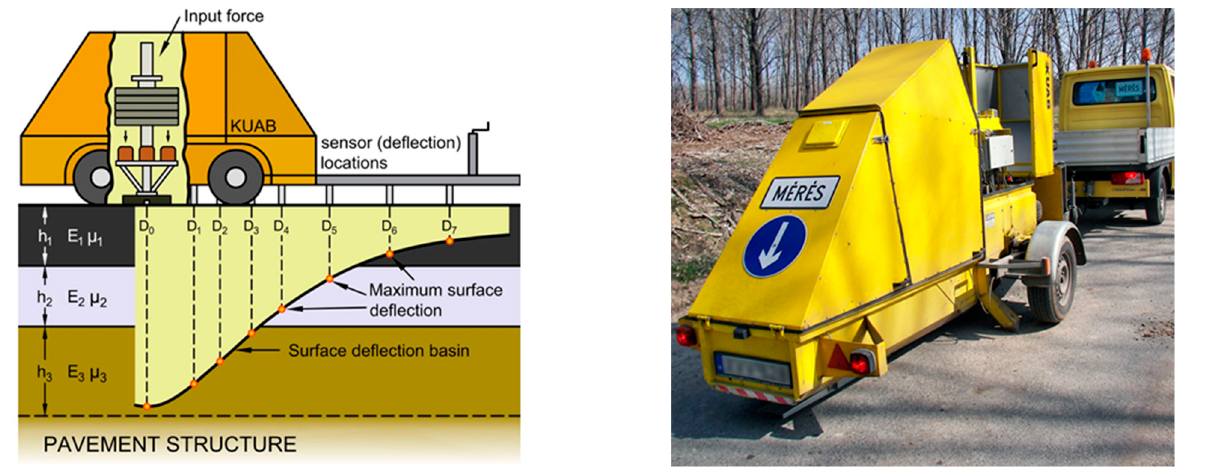
Figure 1. Schematic representation of FWD operation (left) and KUAB FWD testing equipment